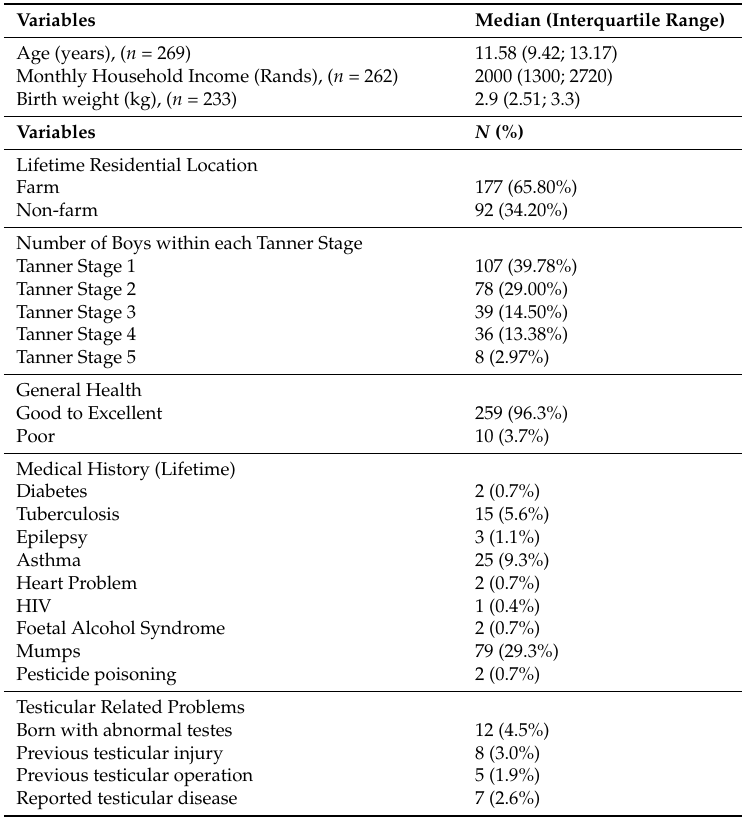
Table 1. Participation, demographic characteristics, socioeconomics